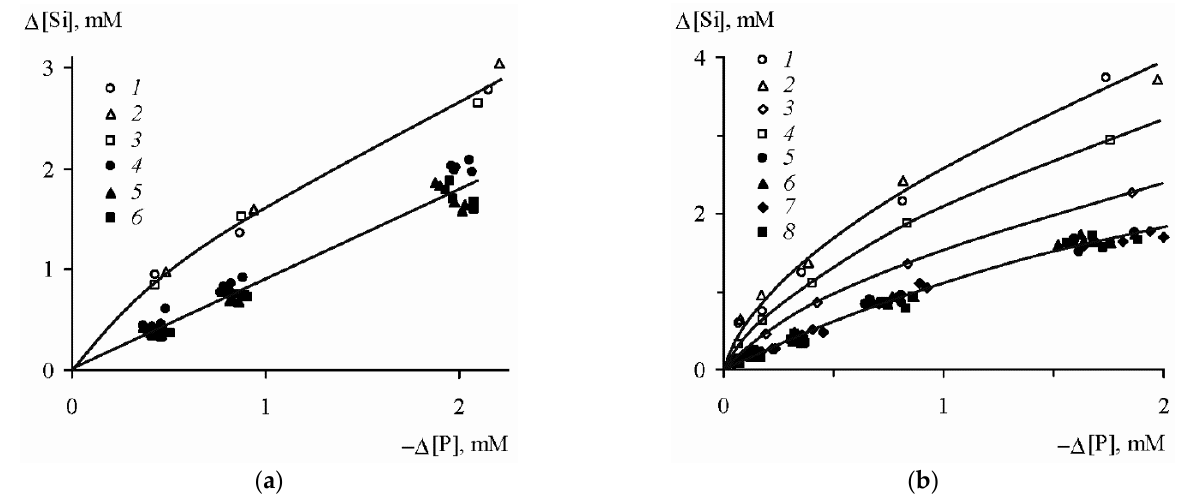
Figure 3. Correlation between variations in the concentrations of phosphorus and silicon in the solution upon phosphotization of silicates [19]. ( a ) pH 1.8: ( 1 ) hornblende, ( 2 ) orthoclase, ( 3 ) labradorite; pH 3.7–8.8: ( 4 ) hornblende, ( 5 ) orthoclase, ( 6 ) labradorite. ( b ) pH 1.8: ( 1 ) kaolinite, Glukhovetsk, ( 2 ) the same, Podol’sk, ( 3 ) montmorillonite, Askania, ( 4 ) the same, near Askania; pH 3.7–8.8: ( 5 ) kaolinite, Glukhovetsk, ( 6 ) the same, Podol’sk; ( 7 ) montmorillonite, Askania, ( 8 ) the same, near Askania. Table 5. Amount of silicon passed into solution in the experiments on phosphatization of silicates at the maximum initial concentration of phosphates 1 , % of the initial concentration in the mineral